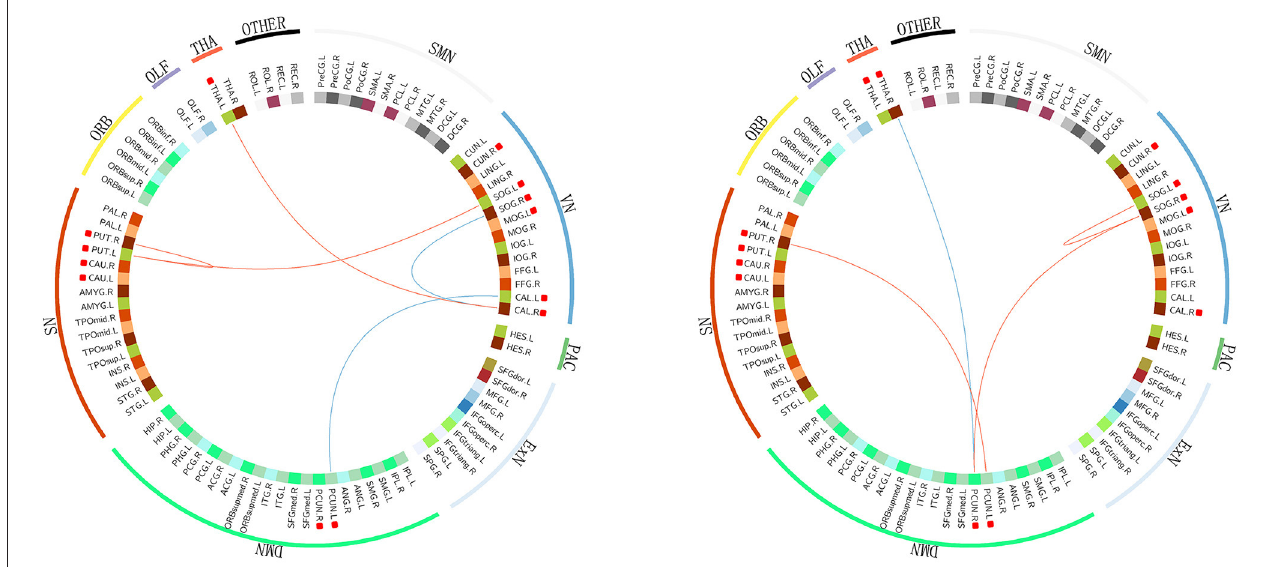
FIGURE 4 | The abnormal rich-club connections are shown in functional networks: red edges denote a positive T score, representing the enhancement of the connection. Blue edges denote a negative T score, representing a decrease in the connection. Hub nodes are highlighted with red square boxes in front. On comparing the HIV + group with HC, increased connections were seen between the left thalamus and the visual network, between the salience and visual networks, and in intra-connection within the salience network. Decreased connections were seen between the visual and default mode networks and in intra-connection within the visual network. On comparing the ANI group with the non-HAND group, increased connections were seen between the visual network and the default mode network, between the salience and default mode networks, and in intra-connection within the visual network. Decreased connections were seen between the right thalamus and the default mode network. The structures located in the visual network included the cuneus, the calcarine fissure and the surrounding cortex, the superior occipital gyrus, and the middle occipital gyrus. Those in the salience network included the putamen and caudate nucleus. DMN, default mode network; SN, salience network; VN, visual network; SMN, sensory motor network; PAC, primary auditory cortex; ExN, executive network; ORB, orbital frontal cortex; OLF, olfactory cortex; THA, thalamus. PCUN, precuneus; SOG, superior occipital gyrus; MOG, middle occipital gyrus; CAL, calcarine fissure and surrounding cortex; PUT, putamen; CAU, caudate nucleus; THA, thalamus; CUN,